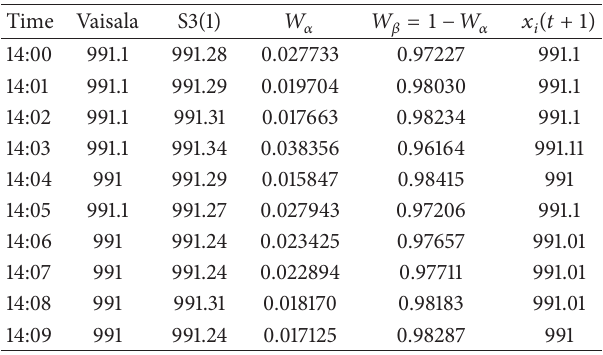
Table 10: Calculated 𝑊 𝛽 of different device